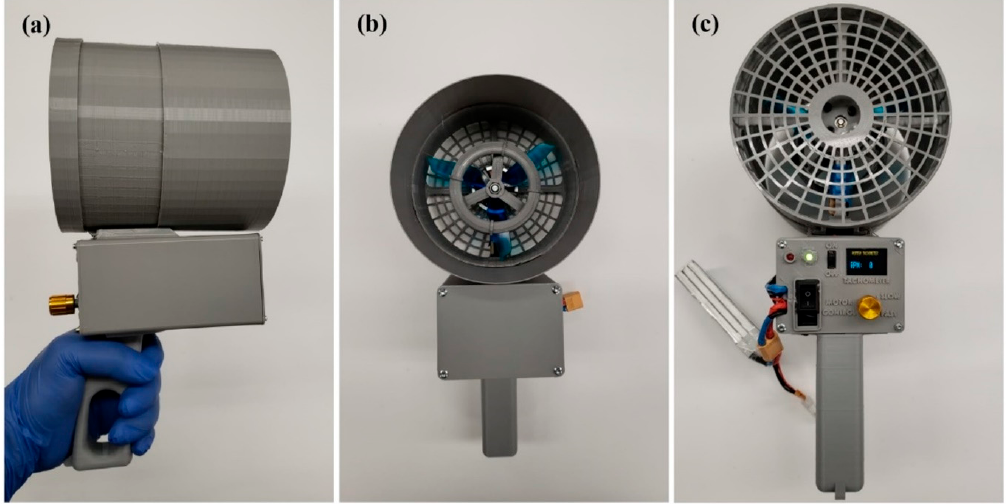
Figure 7. 3D-printed Handheld Device (HD): ( a ) side view, ( b ) front view, ( c ) rear view.